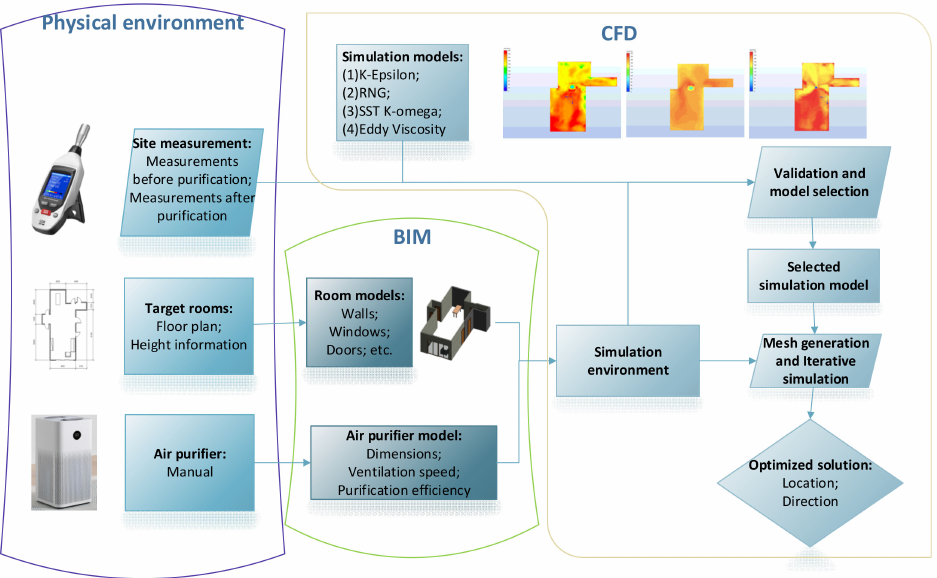
Figure 1. The proposed framework for operation optimization of air